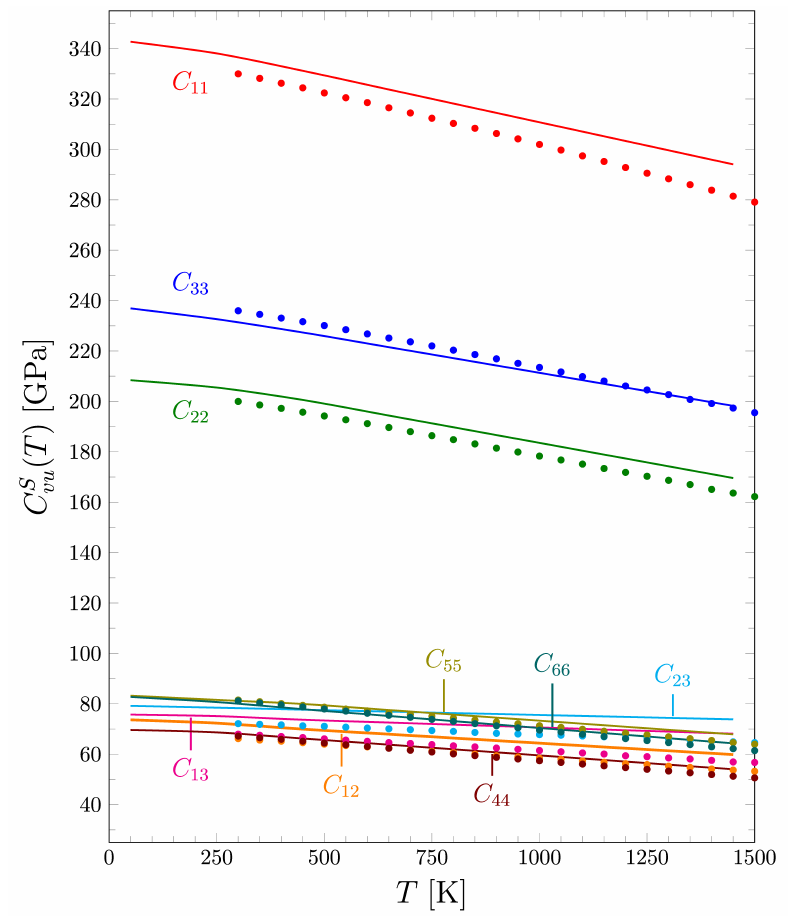
Figure 3. Adiabatic single-crystal elastic stiffness constants of forsterite as a function of temperature. Circles are experimental data by Isaak et al. [32] while lines correspond to fully quasi-harmonic computed